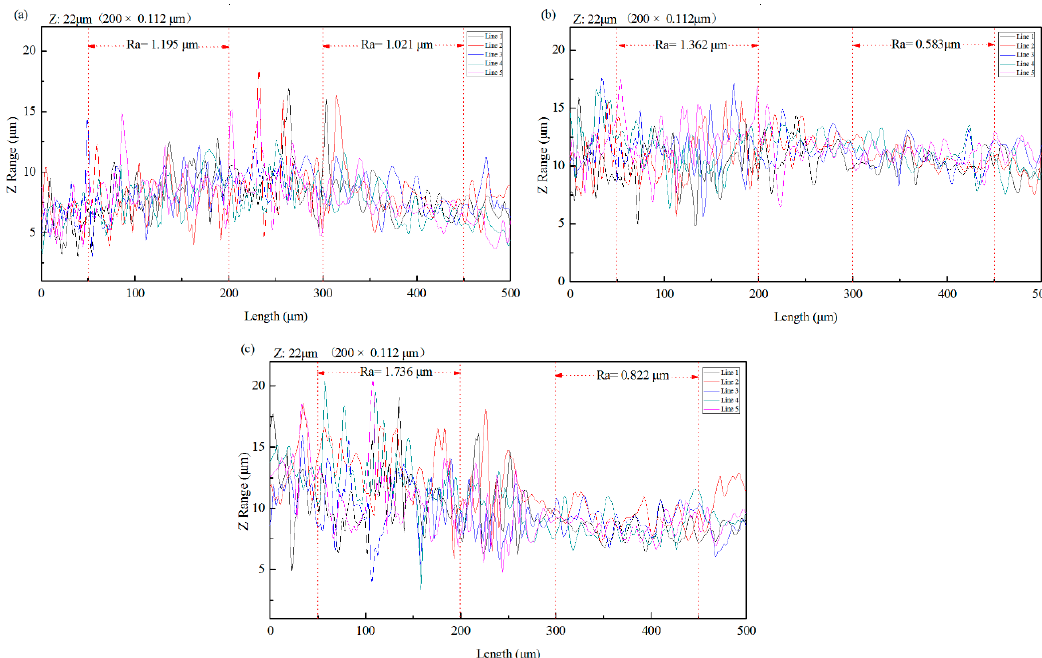
Figure 1. Surface 3D topography comparison of untreated and TCP-treated regions within one Zn55Al specimen surface with different immersion periods: ( a ) 30 s; ( b ) 180 s; ( c ) 360 s at 40 ° C in the TCP bath.